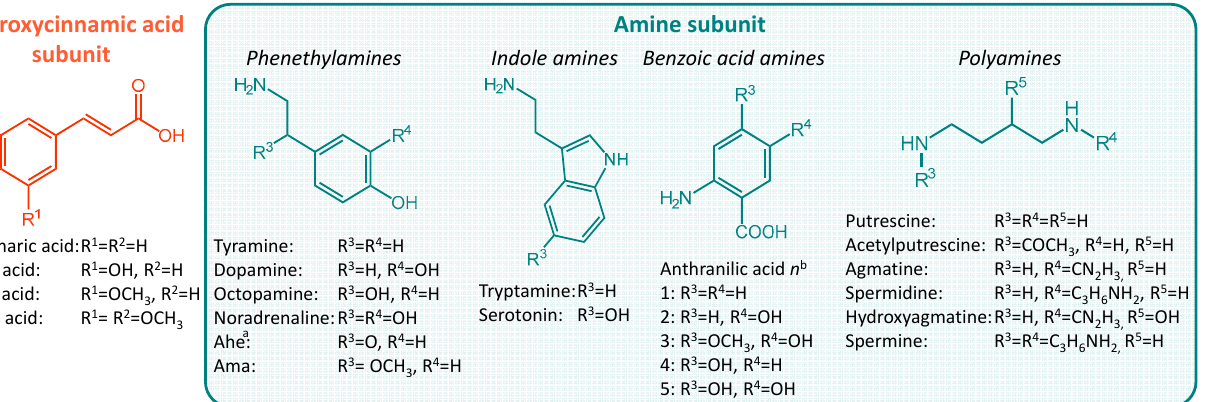
Figure 1. Overview of hydroxycinnamic acid and amine subunits present in naturally occurring phenol amides [4,5]. a Ahe, 2-amino-1-(4-hydroxyphenyl)ethanone; Ama, α -(aminomethyl)-4-methoxybenzyl alcohol b The n in Antn is replaced by the number of the corresponding acid.